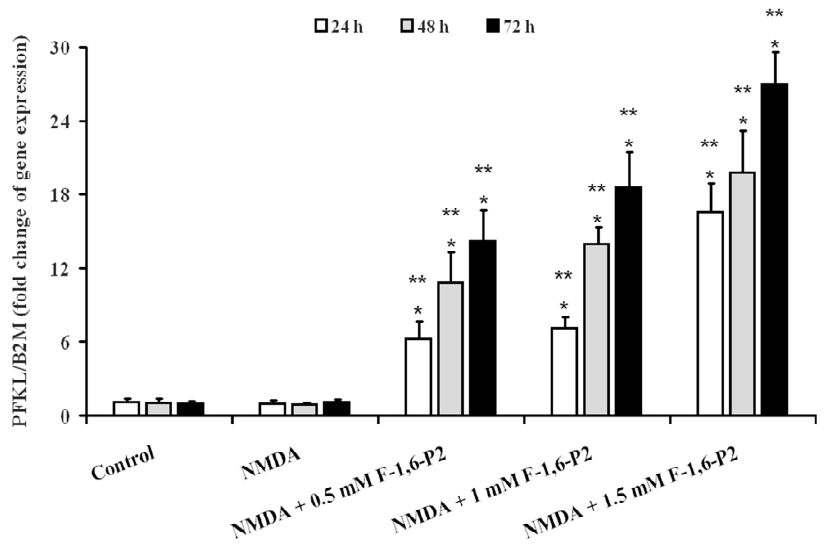
Figure 7. Effects of F-1,6-P2 on gene expression of 6-phospho-1-fructokinase (PFKL) in NMDA-treated OHSC. OHSC were challenged with 30 μ M NMDA for 3 h and then incubated without and with increasing concentrations of F-1,6-P2 (0.5, 1 and 1.5 mM) for different times (24, 48 and 72 h). Control OHSC were incubated for the same time intervals, with no prior NMDA treatment or F-1,6-P2 addition. Semi-quantitative PFKL expression was determined in cell extracts, relatively to the housekeeping gene β -2-microglobulin (B2M). Histograms are the mean of 6 different OHSC preparations. Standard deviations are represented by vertical bars. * Significantly different from corresponding time of control OHSC, p < 0.001. ** Significantly different from corresponding time of NMDA-challenged OHSC with no F-1,6-P2 supplementation, p < 0.001.